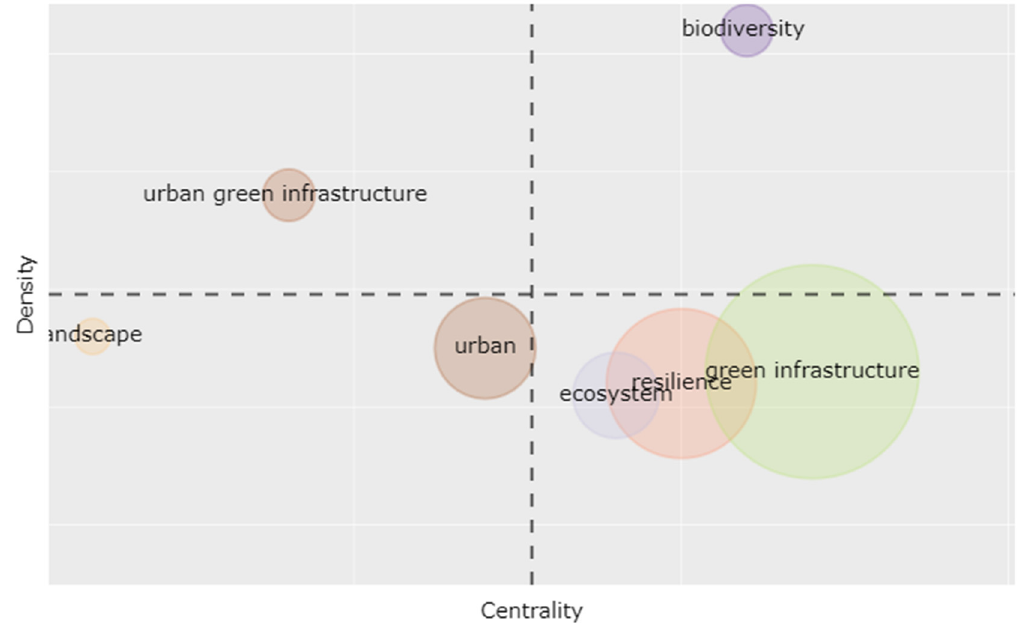
Figure 10. Thematic Map by Author Keywords. Source: Biblioshiny. Own compilation.